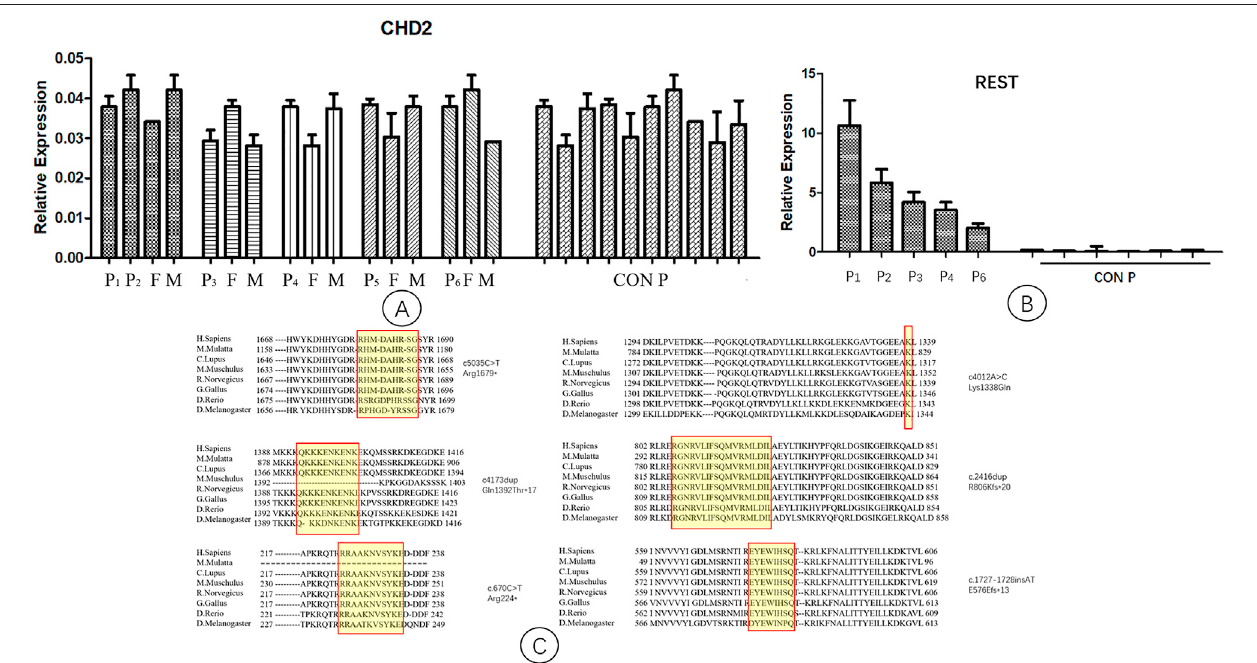
FIGURE 2 | Quantitative PCR analysis of CHD2 and REST gene expression. P1-P6, patient 1 – 6; F, father; M, mother; CON P, control group. Arabic numerals represent the age of the control group. (A) The expression levels of the CHD2 gene in patients, parents, and the controls. They were not signi fi cantly different. (B) The expressionlevelsofthe REST geneinpatientsandthecontrols.Thelevelsof REST geneexpressioninthepatientsweresigni fi cantlyhigherthanthoseofthecontrols. (C) Conservation studies were conducted for CHD2 mutations reported in this manuscript in H.Sapiens, M.Mulatta, C.Lupus, M.Muschulus, R.Norvegicus, G.Gallus, D.Rerio, D.Melanogaster. All the mutations in this study were relatively stable.